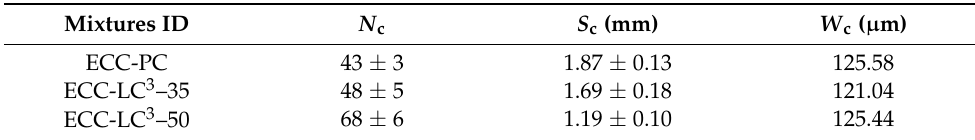
Table 8. Fiber dispersion coefficient.